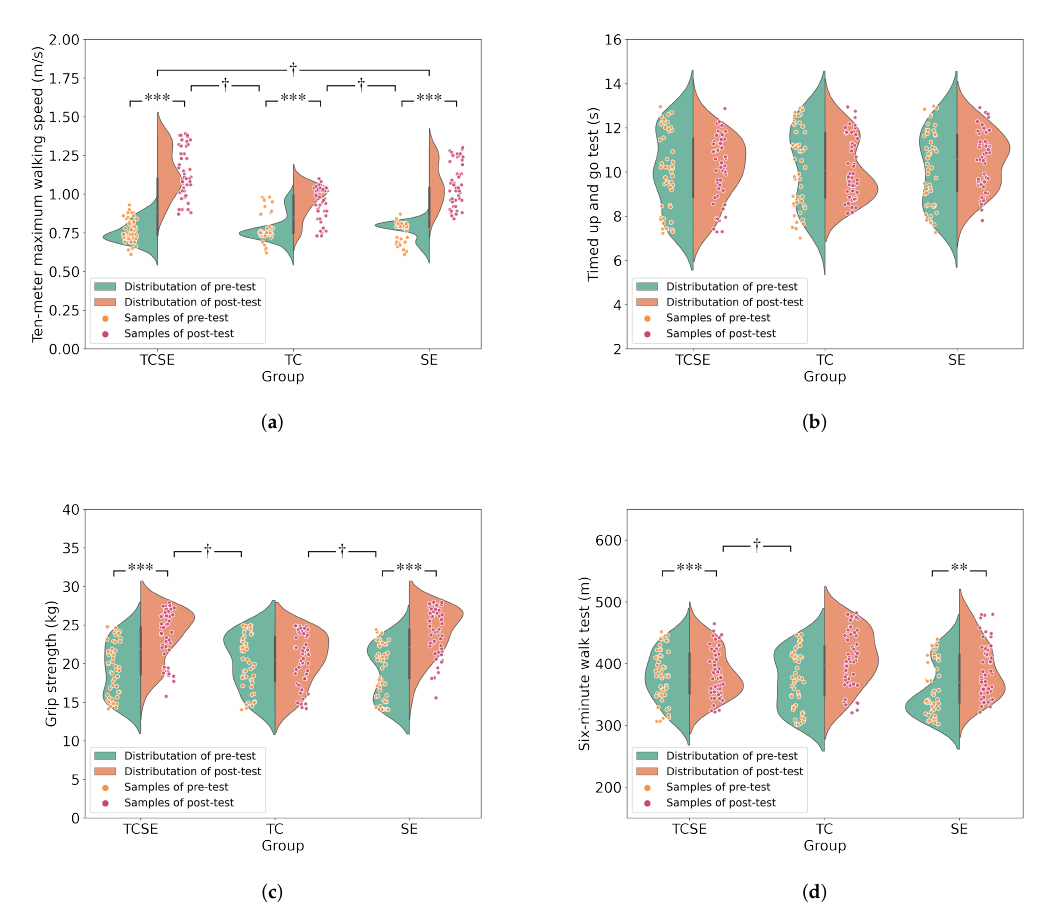
Figure 2. The figure is the scatter plot with the addition of a rotated kernel density plot on each side; it shows the physical ability of the frail elderly at baseline and post-intervention. ( a ) The ten-meter maximum walking speed, ( b ) TUGT, ( c ) grip strength, and ( d ) six-minute walk test. TC indicates Tai Chi group; TCSE indicates Tai Chi, strength, and endurance group; SE indicates strength and endurance group. ** p < 0.01, *** the significance of intragroup differences ( p < 0.001), † the significance difference among groups ( p < 0.05). Table 2. Two-way repeated measures ANOVA results for each group at baseline and 24 weeks for the test